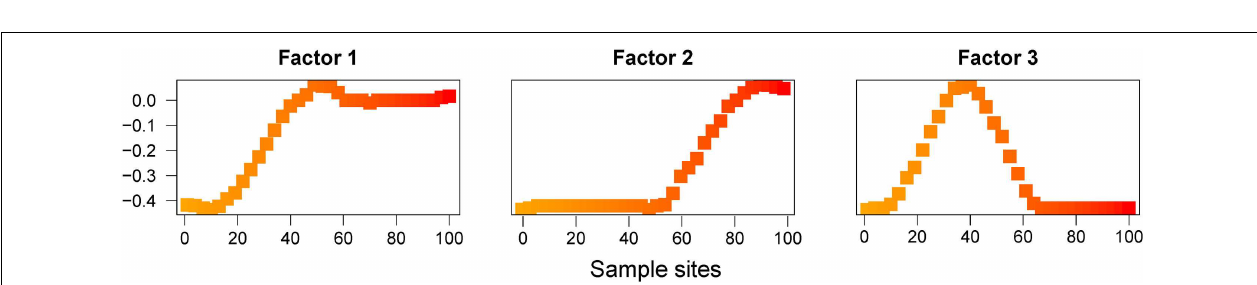
Based on PC and factor plots, we next computed Wilks’ (cid:51) sta- tistic for all methods, and for divergence times τ ranging between 0 and 100 ( Figure 6 ). Lower values of (cid:51) generally indicated better discriminationof